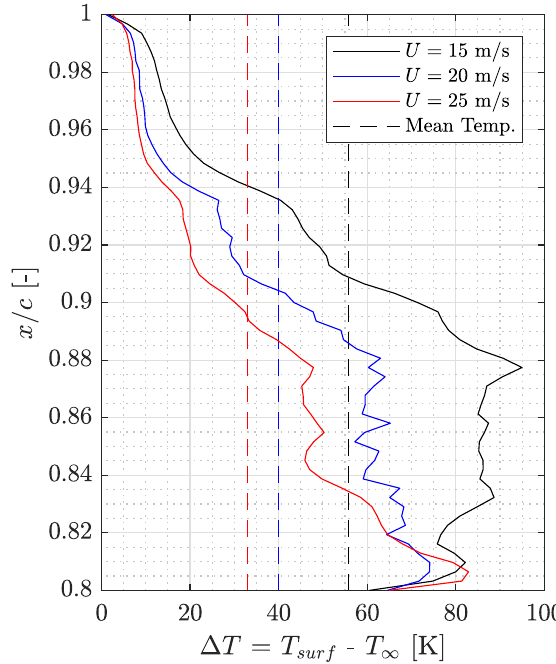
Figure 3. Temperature distribution of heated porous trailing edge for different flow